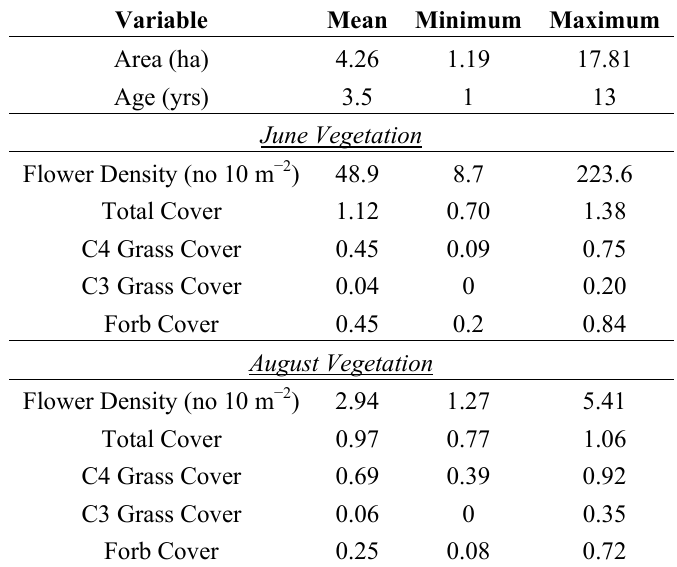
Table A1. Characteristics of 10 conservation grasslands used as study sites in Southwest Ohio.